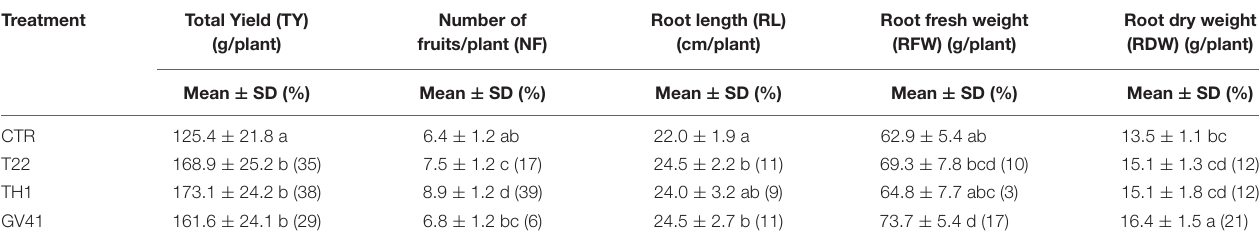
TABLE 1 | Effects of different Trichoderma strains (T22, TH1, and GV41) on the growth and productivity of strawberry plants under greenhouse conditions. Treatment